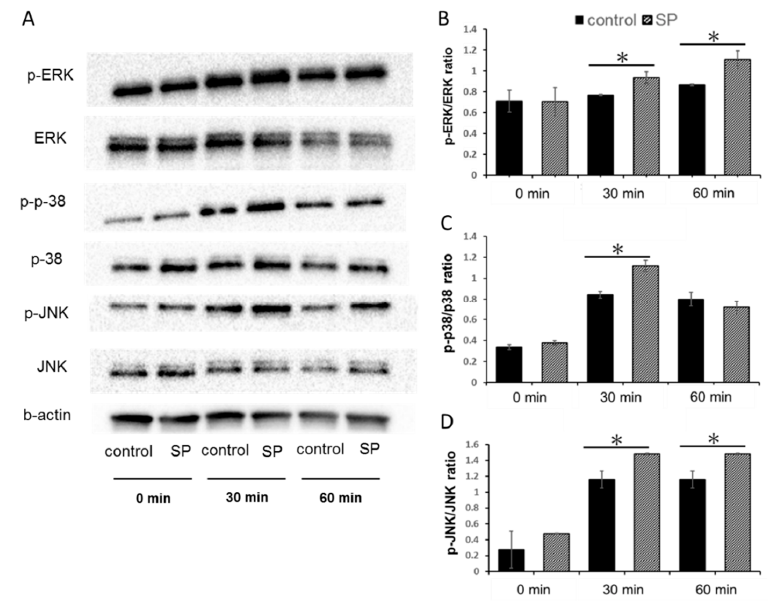
Figure 5. Phosphorylation of the mitogen-activated protein kinase (MAPK) signaling pathway of SP. Dental pulp stem cells (DPSCs) were treated with SP (0 or 100 ng / mL) for 0, 30, or 60 min. Protein expression was evaluated by immunoblotting analysis. ( A ) Protein expression of ERK 1 / 2, JNK, p-38, phospho-ERK 1 / 2, phospho-JNK, and phospho-p-38. ( B ) The ratio of phospho-ERK 1 / 2 intensity: The expression levels of the phospho-ERK 1 / 2 / ERK 1 / 2 ratio were increased at both 30 and 60 min. ( C ) The ratio of phospho-p38 intensity: The expression levels of the phospho-p38 / p38 ratio were increased at 30 min. ( D ) The ratio of phospho-JNK intensity: The expression levels of the phospho-JNK / JNK ratio were increased at both 30 and 60 min. (* P >